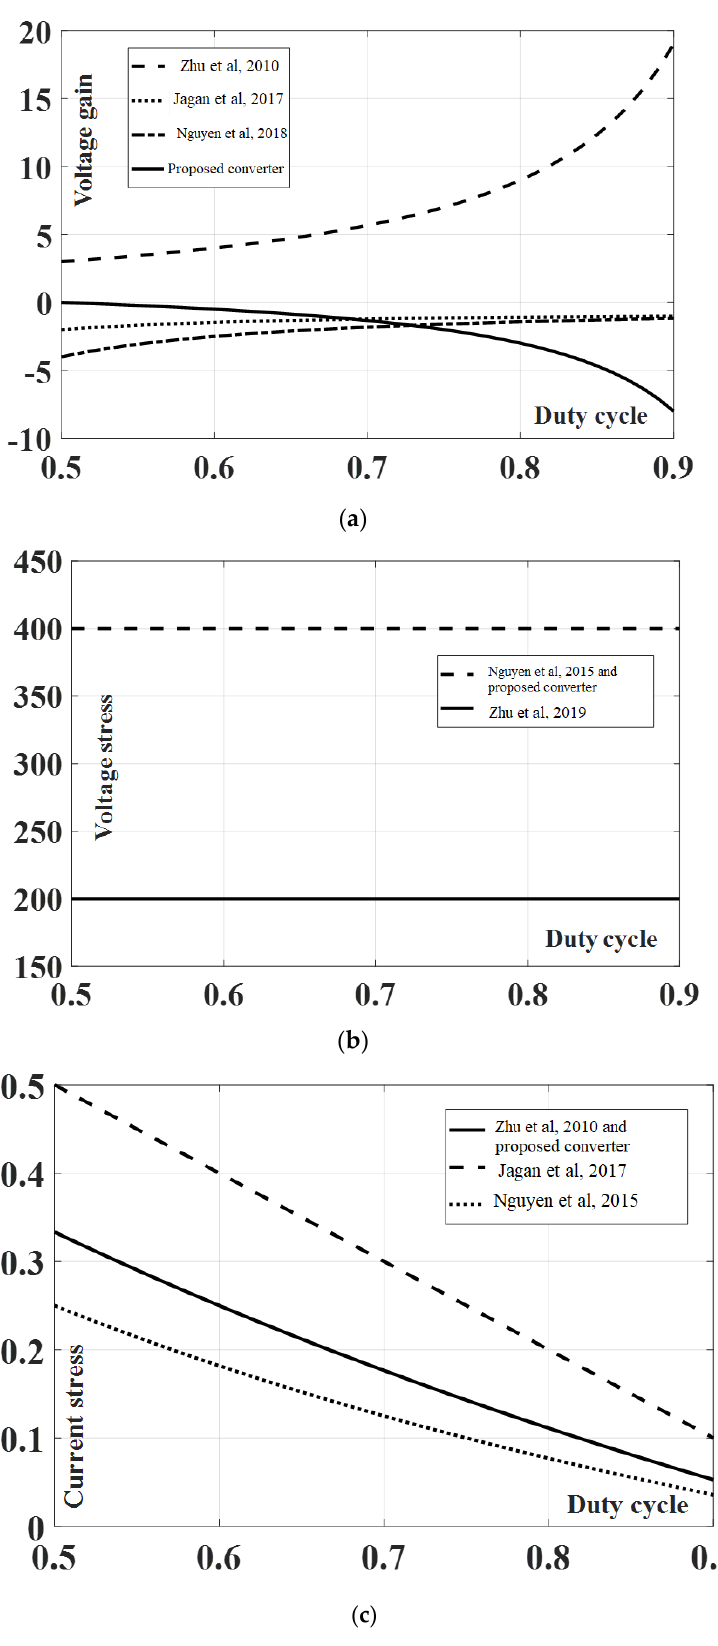
Figure 13. ( a ) Voltage gain: ( b ) voltage and ( c ) current stresses of the proposed QZSI in comparison with inverters in [16 – 20] and [51,52].